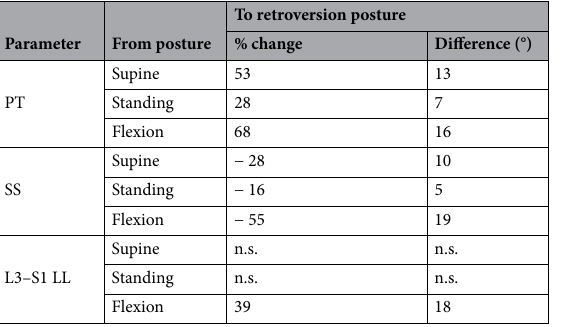
Table 6. Summary table of significant effects of retroversion posture on bony pelvic geometry parameters (P < 0.05, Neuman-Keuls significant). Percent change in parameter and difference are listed. (n.s. =